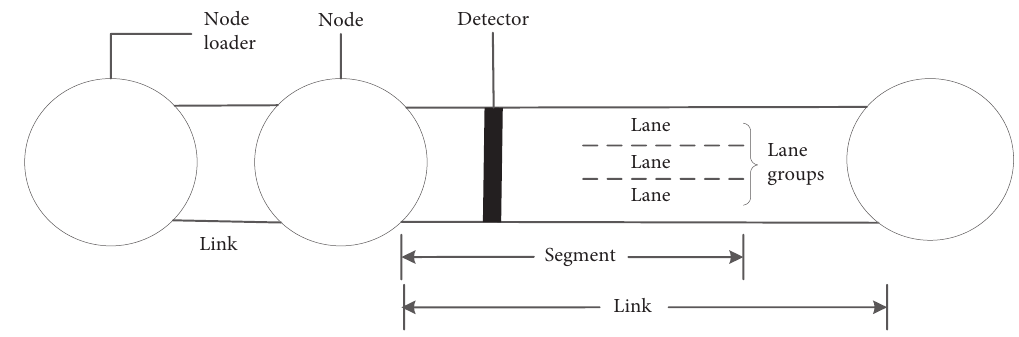
Figure 1: Road network